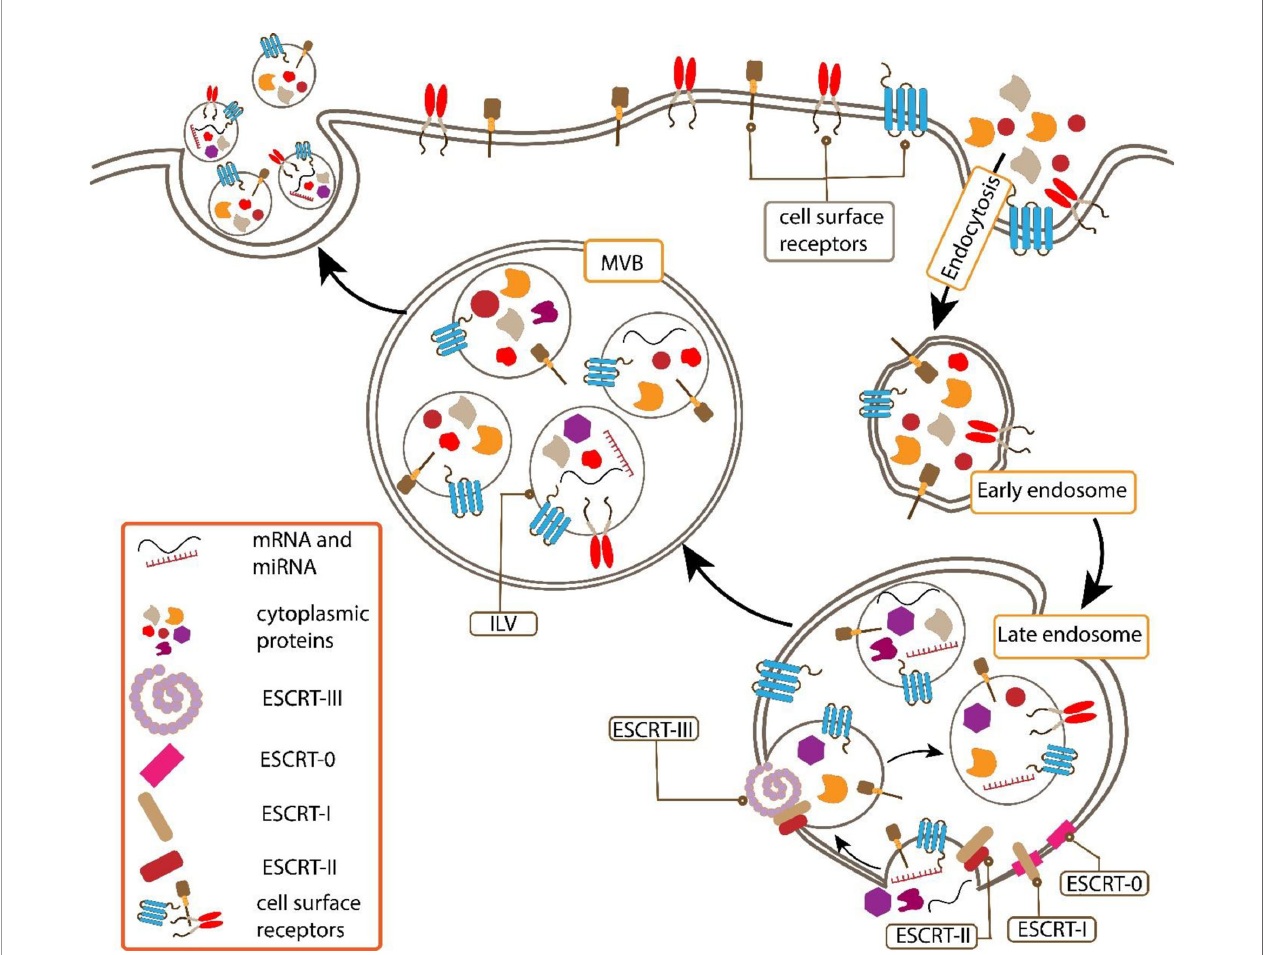
FIGURE 1 | Early endosomes mature into late endosomes and exosomes are formed by inward budding of the multivesicular body (MVB) membrane. Intraluminal vesicles (ILVs) are formed by the Invagination of late endosomal membranes within large MVBs. It has been demonstrated that the endosomal sorting complex required for transport (ESCRT) machinery is important in this